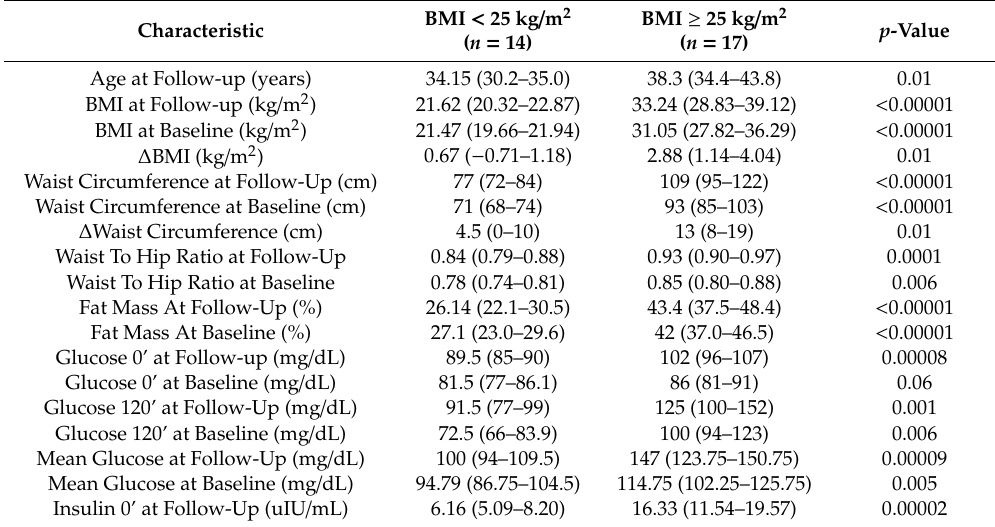
Table 2. Metabolic characteristics of the participants according to BMI group.